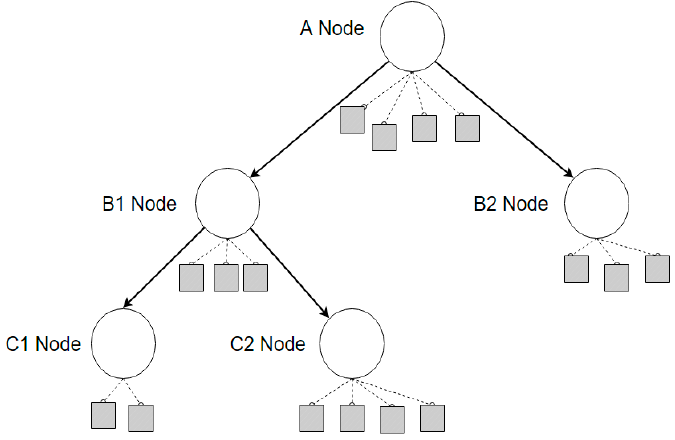
Figure 2. Grid computing method in a tree overlay network structure.